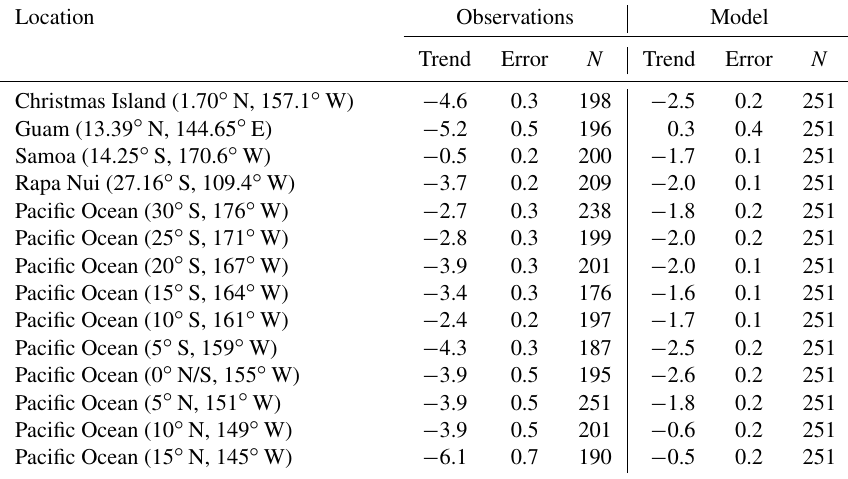
Table 6. Estimated trends of surface CO in the Pacific Ocean according to observations and model outputs for the period 1994–2014. Trends are calculated following Lamsal et al. (2015) and errors as in Tiao (1990). The number of data points ( N ) considered is also indicated. Trends and errors are in ppbv per